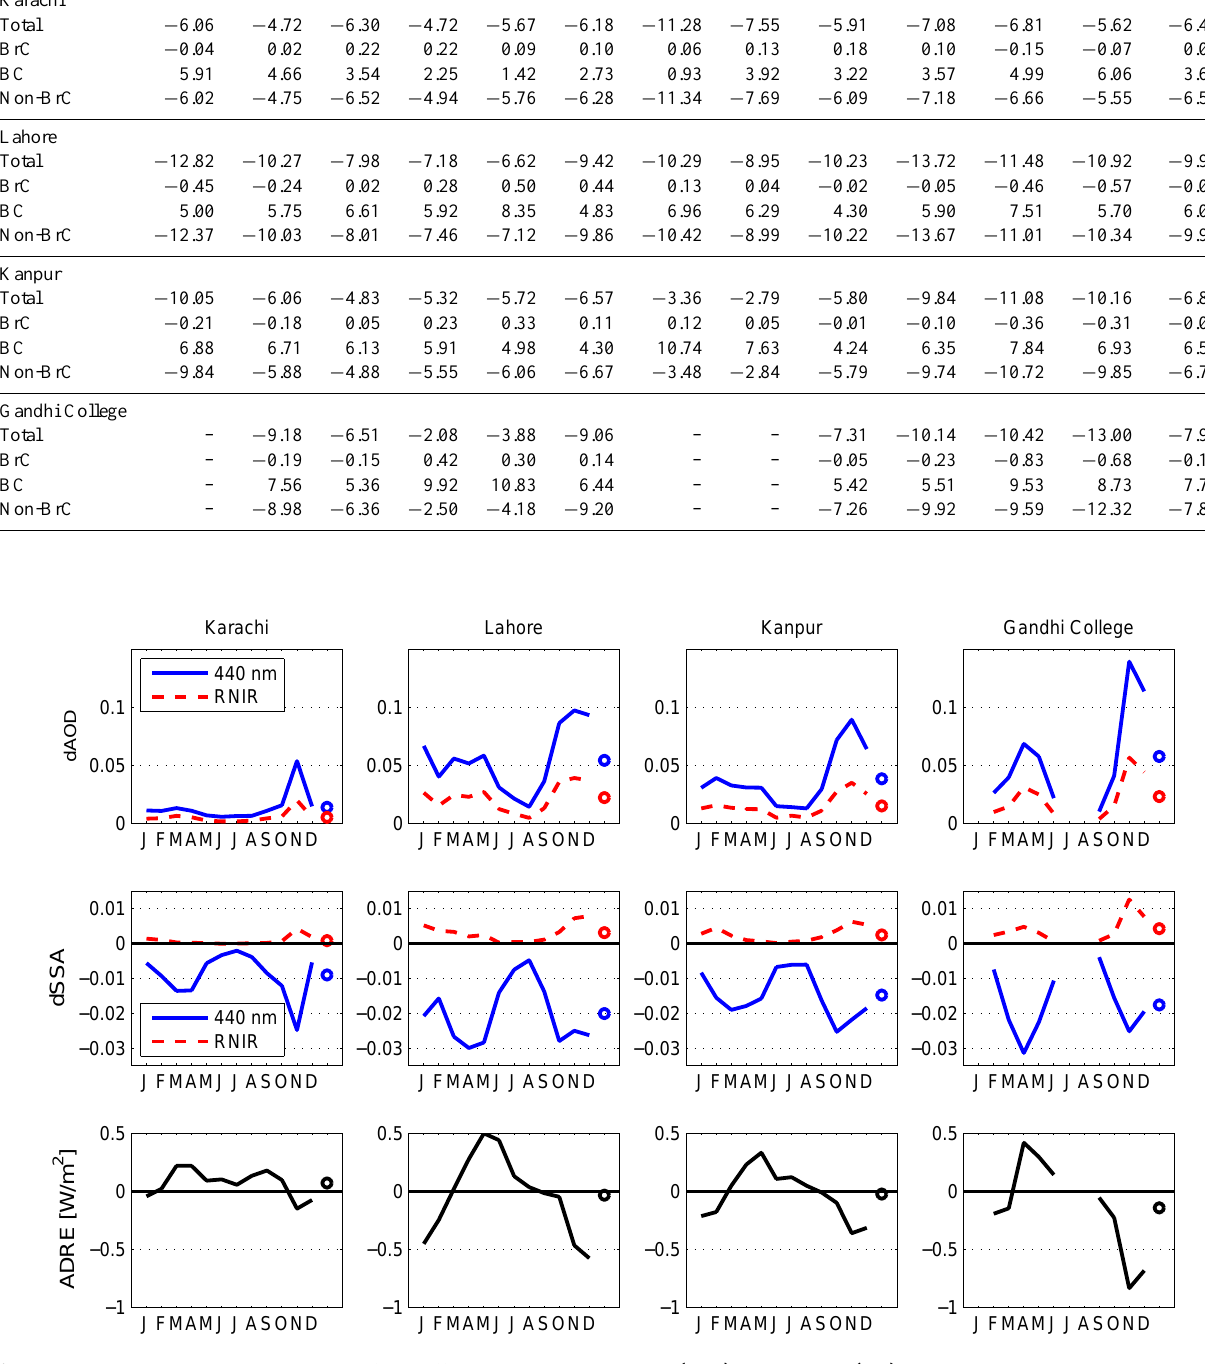
Figure 5. Upper panel: monthly averages of the difference in AOD at 440nm (blue) and at RNIR (red) between simulations with and without BrC. Middle panel: corresponding cases for SSA. Lower panel: monthly average DRE of BrC. Corresponding annual averages are given by the symbol after